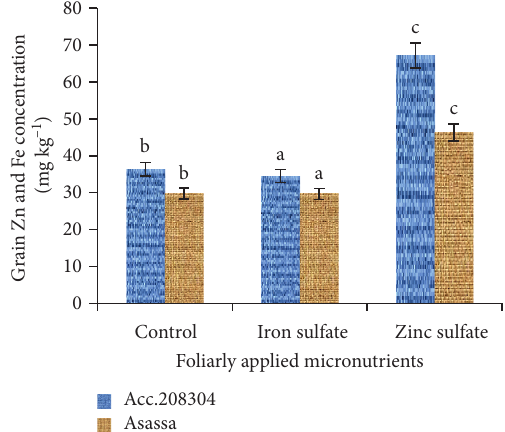
Figure 2: Response of the tested varieties to the applied zinc and iron fertilizers under deficit soil condition (mg kg − 1